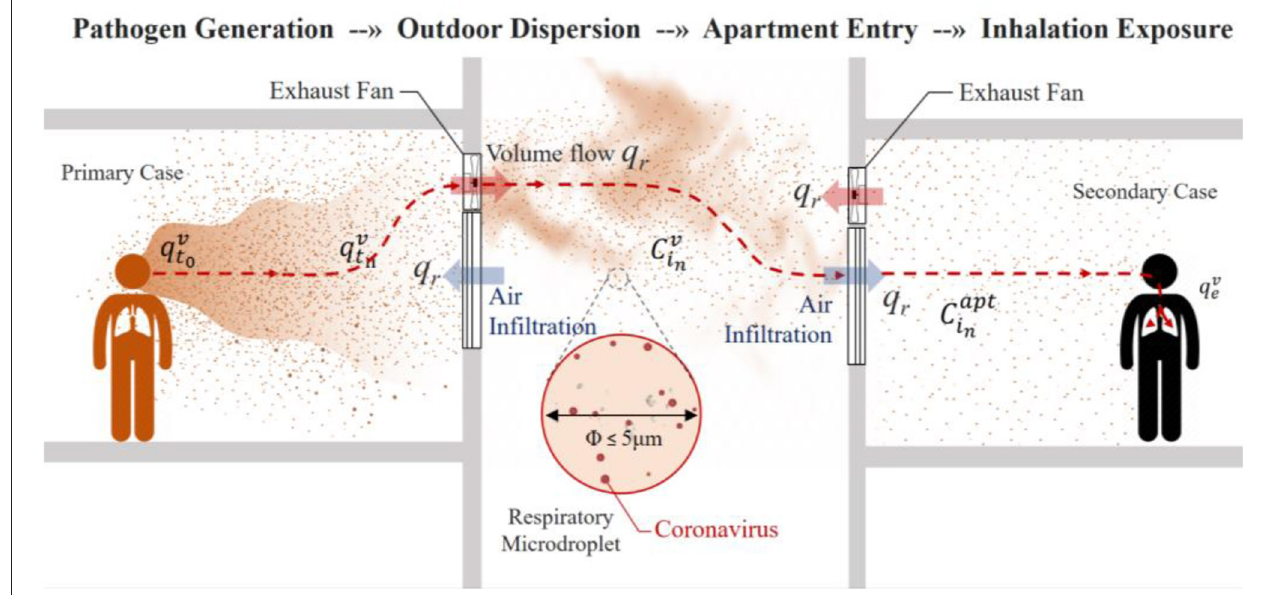
FIGURE 1 | A conceptual framework of airborne transmission of coronavirus consisting of pathogen generation, natural decay, outdoor dispersion, and apartment